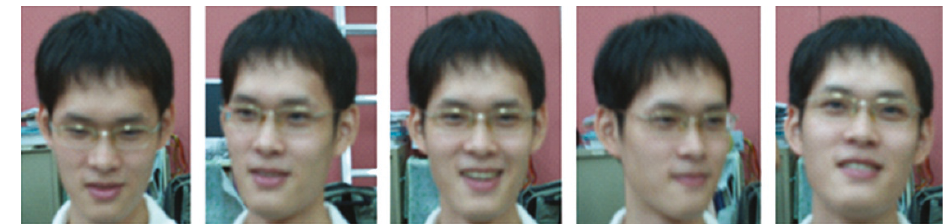
Figure 12: Five di ff erent head orientations of a